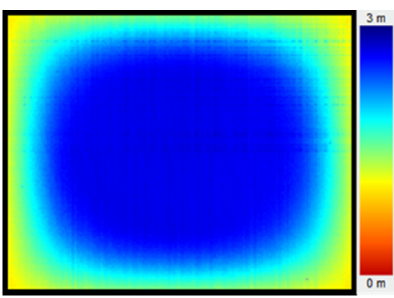
Figure 4. Non-uniform measurement due to uneven temperature distribution.